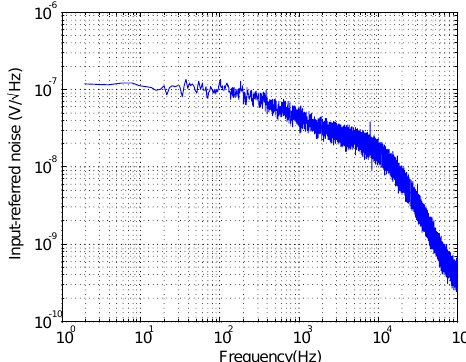
Figure 14. Measured LNA input-referred